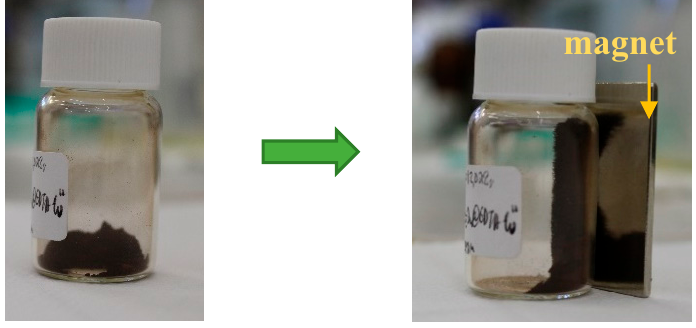
Figure 7. Magnetic manipulation of Fe 3 O 4 @EDTA ‐ Mn 2+ ( 1 ) MNPs using an external magnet.